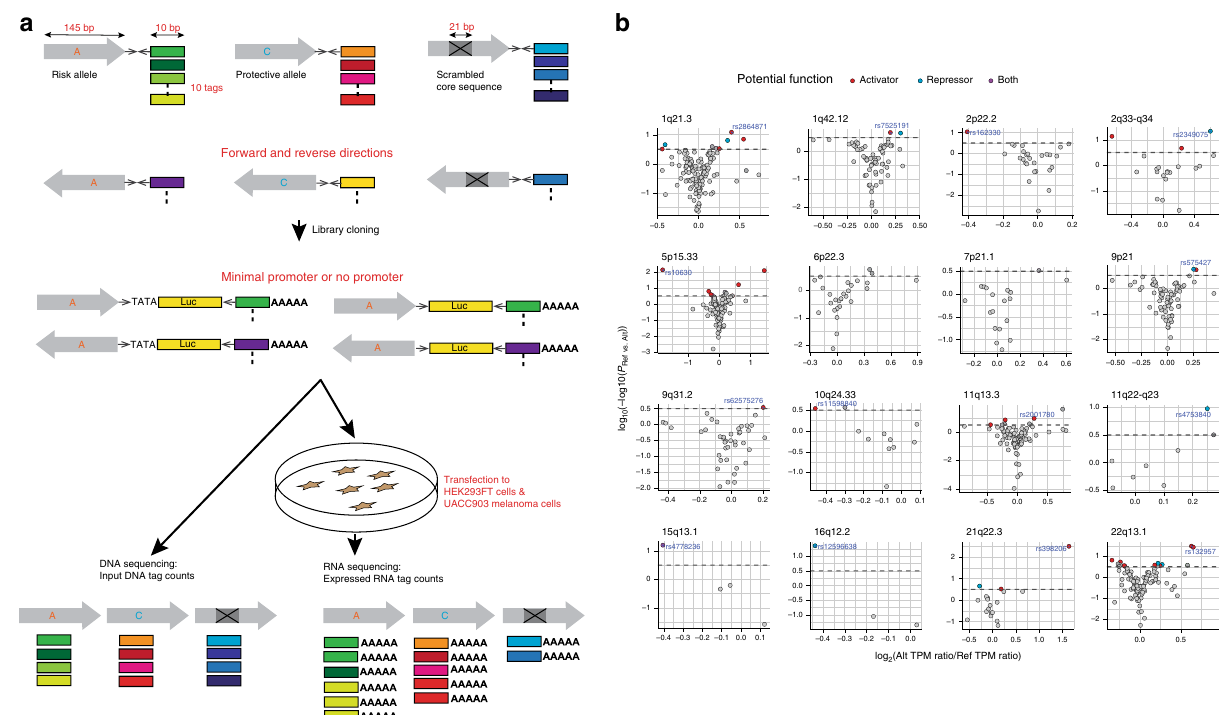
Fig. 1 MPRA identi fi ed 39 functional variants from 16 melanoma GWAS loci. a MPRA work fl ow. Oligo libraries were synthesized using 145 bp of sequence encompassing each variant with risk or protective alleles or a scrambled sequence for core 21 bases in both forward and reverse directions, that was fl anked by enzyme recognition sites and sequencing primer sequences, as well as 10 bp barcodes (10 tags per unique sequence). Libraries were cloned into luciferase constructs with or without a minimal TATA promoter. Cloned libraries were then transfected into HEK293FT cells or UACC903 melanoma cells to generate expressed RNA tag libraries. Both input DNA and RNA libraries were sequenced to assess the tag counts associated with the test sequences. Luc: luciferase gene, AAAAA: poly-A tail. b Volcano plots of MPRA results for each melanoma GWAS locus. Inverse P-values and effect sizes of allelic difference from UACC903 transfections are shown for each of the 16 loci tested. A two-sided Wald test with robust sandwich type variance estimate was used. Multiple comparisons were adjusted using the Benjamini and Hochberg method. Dashed horizontal lines indicate the FDR 1% cutoff for allelic difference in the UACC903 set. The most signi fi cant variant from each locus is labeled. Putative function of 39 signi fi cant MPRA variants are shown as activator (red circle), repressor (blue circle), or both (purple circle) (expression levels of either allele is higher, lower, or higher and lower than those of scrambled sequence, respectively). Gray variants above the FDR 1% cutoff are those that failed additional criteria (allelic difference in the combined data or signi fi cant departure from the scrambled control). No signi fi cant variants were identi fi ed from the loci on Chr6p22.3 and Chr7p21.1. Source data are provided as a Source Data fi